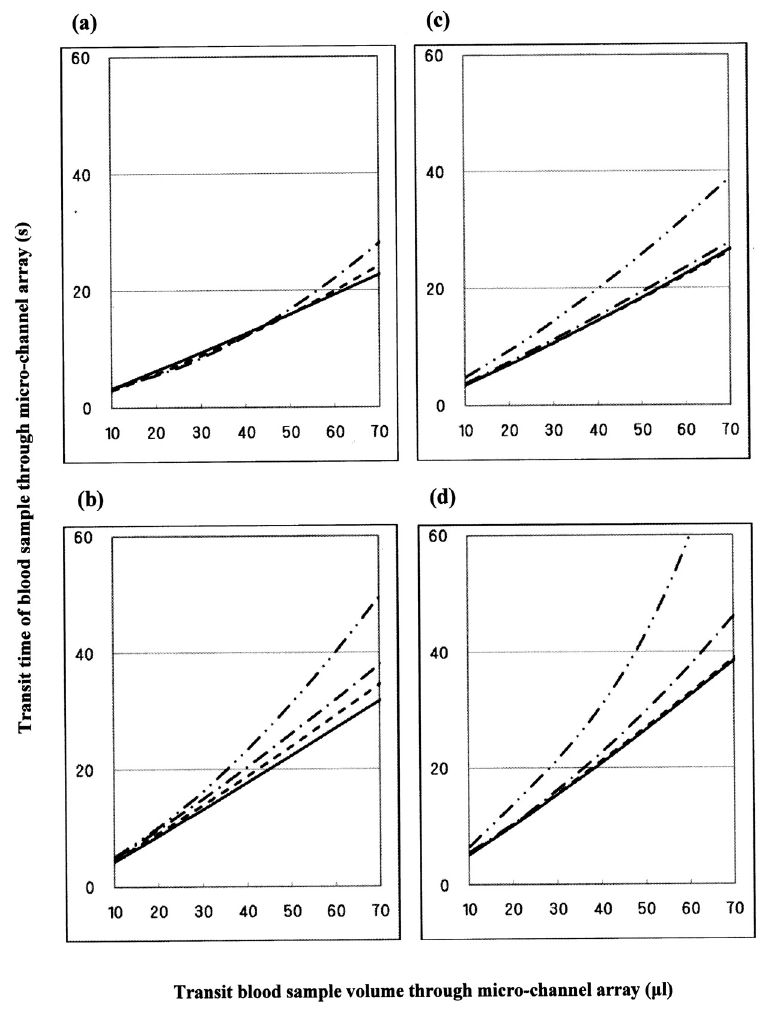
Figure 18. Representative examples ( n = 4) of blood fluidity measured in terms of transit time against transit sample volume, redrawn from Sugawara et al. [24]. Solid lines represent the temperature-untreated control; broken lines represent samples treated at 37 °C; one-point lines represent samples treated at 42 °C; two-point lines represent samples treated at 45